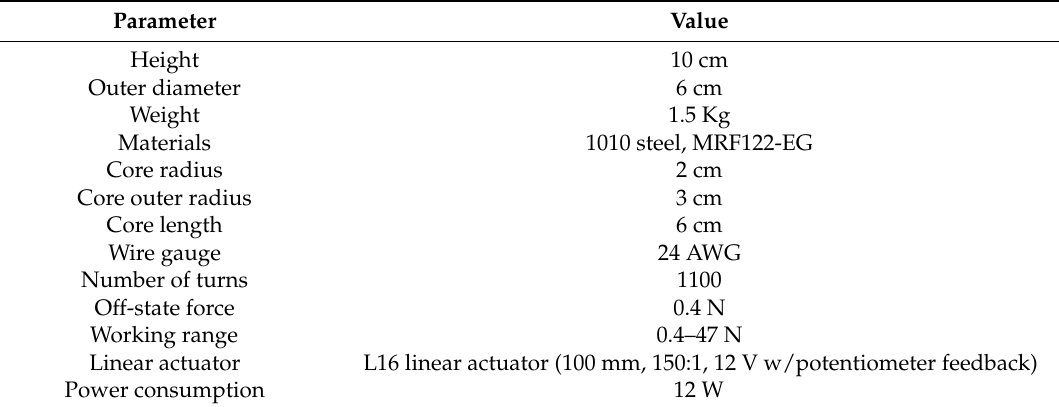
Table 2. Summary of FGM design and performance parameters.